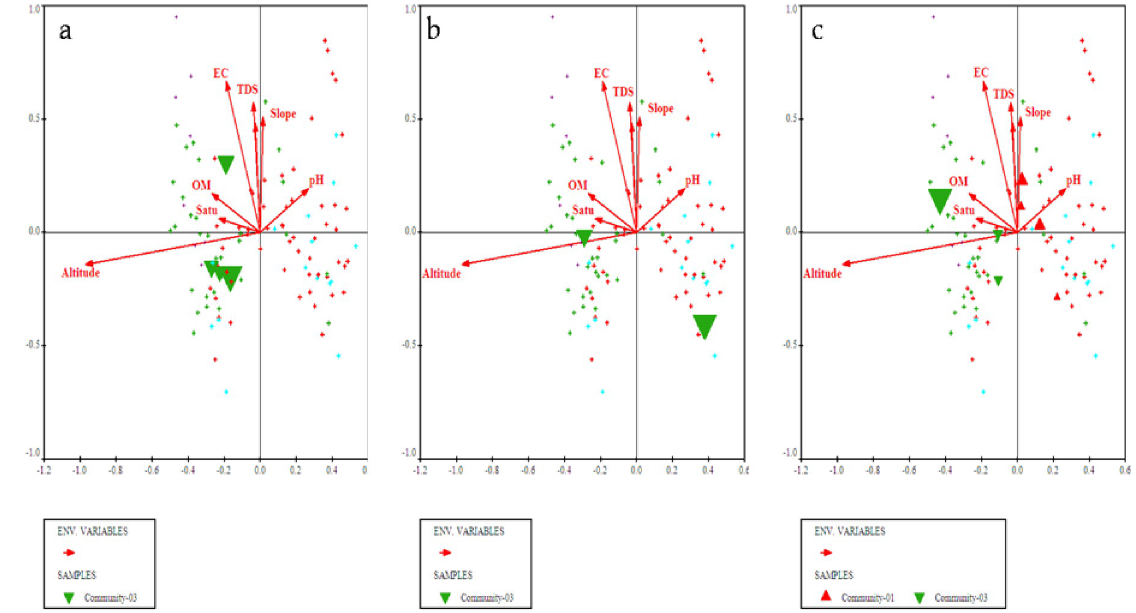
Fig 5. CCA bi-plot of top most indicators i.e., (a) Cedrus deodara , (b) Elaeagnus umbellata and (c) Hypericum perforatum concerning measured environmental factors.